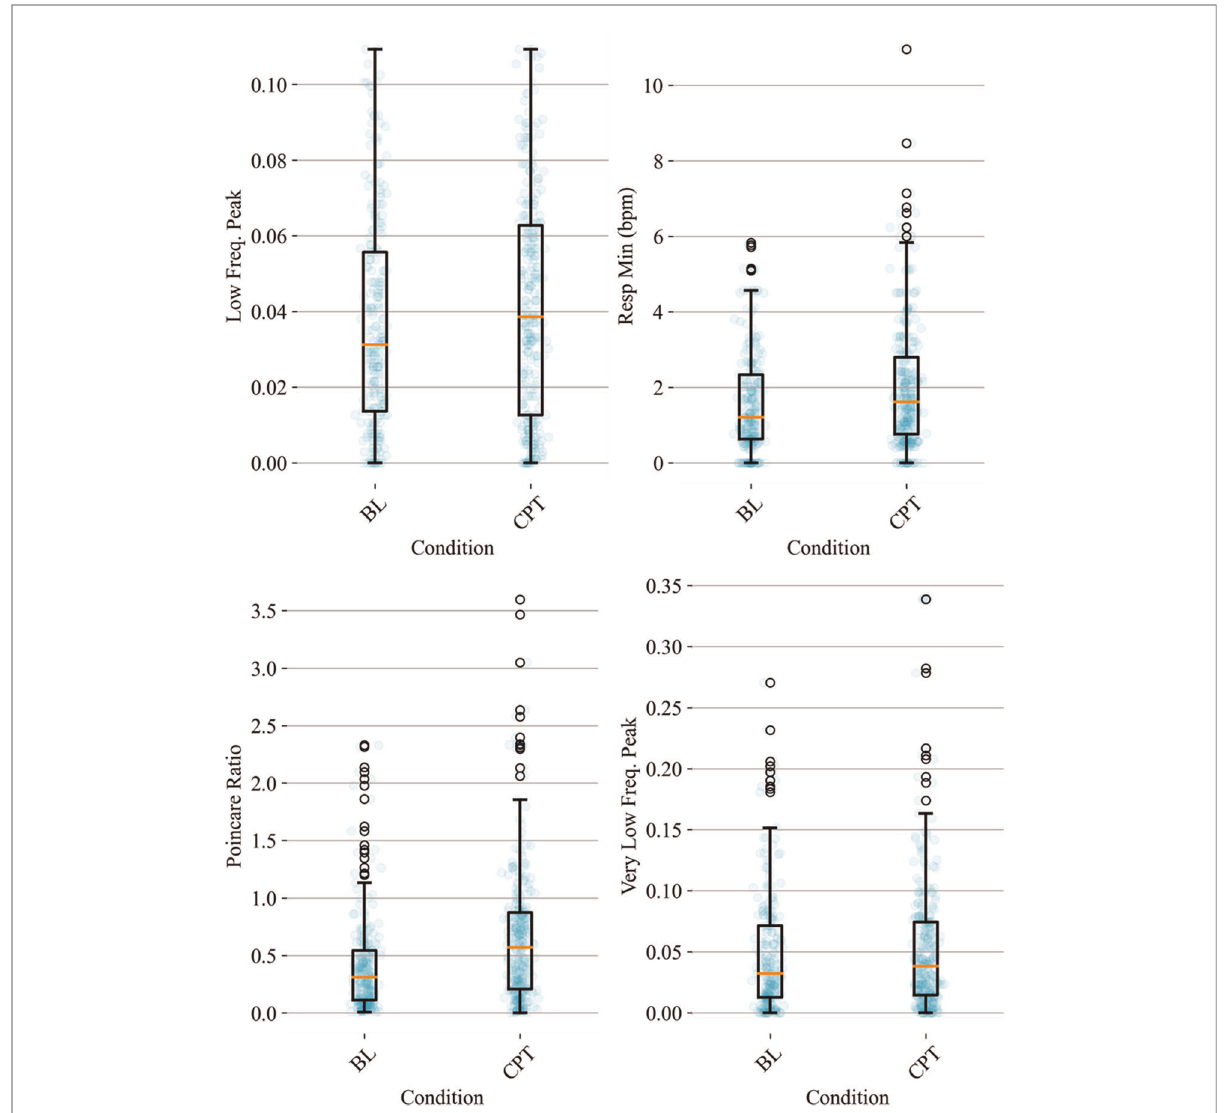
FIGURE 4 Baseline-normalized, non-HRV time domain features contributing least to the model included low frequency (LF) peak, the minimum respiration rate, Poincare ratio, and very low frequency (VLF) peak. The data overlay on each boxplot represents the entire dataset (blue circles) used to generate the corresponding boxplot with medians shown in red and outliers shown as black circles.